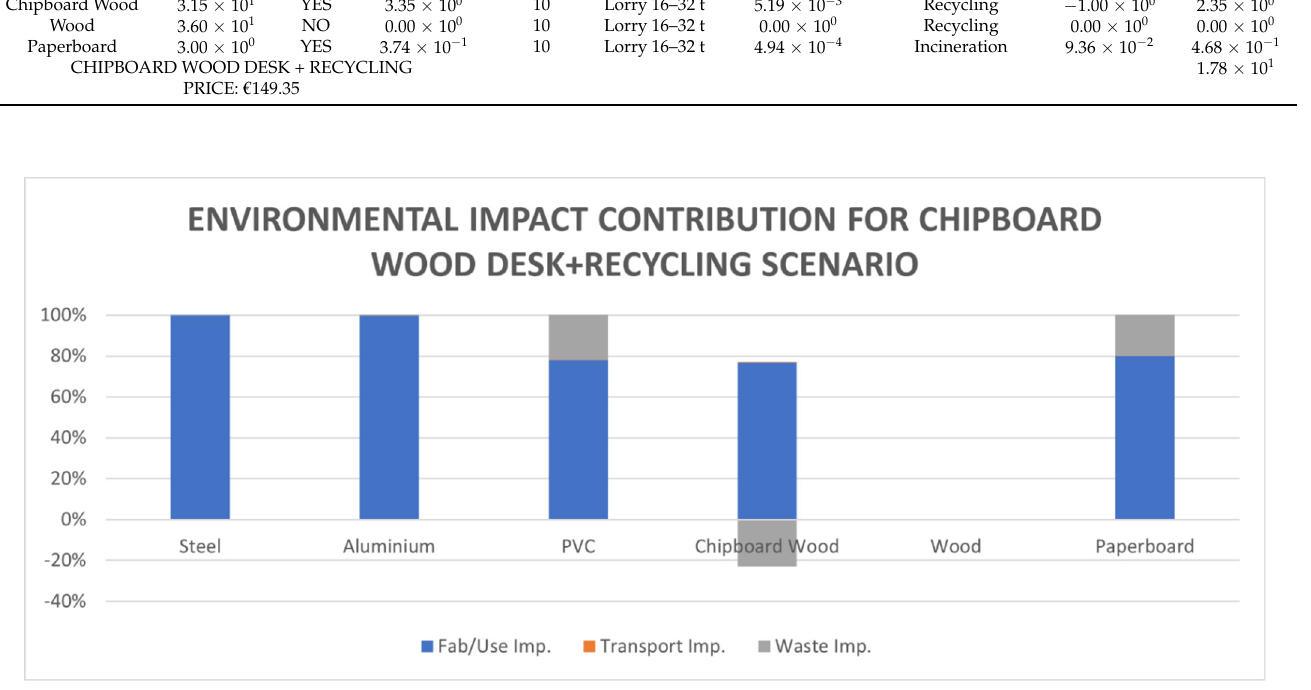
Figure 4. Environmental impact contribution for chipboard wood desk + recycling scenario. If, in addition to choosing wood and facilitating the option of its final recycling, the amount of material needed to manufacture the desk is reduced by 30% in wood and 20% in metal, the environmental impact would decrease by 5.7 × 10 0 pt. The total impact of this design would be 1.33 × 10 1 pt. (see Table 12 and Figure 5). The reduction in materials presented in this scenario maintains the minimum requirements of the desk design but changes the shape of the desk by making it round instead of the original square and thus eliminating part of the trims. With these modifications, the materials and the final weight of the table are reduced while the basic dimensions of 180 × 80cm are maintained but with a narrower central area. Table 12. Results of chipboard wood desk + reduced materials + recycling scenario.